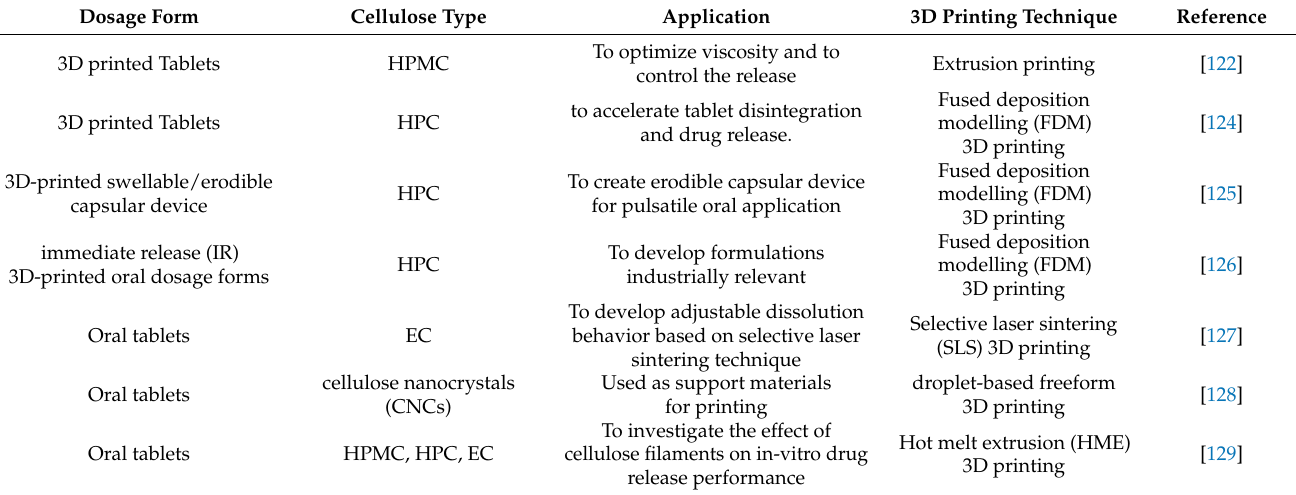
Table 4. Examples of cellulose derivatives used by 3D printing for oral